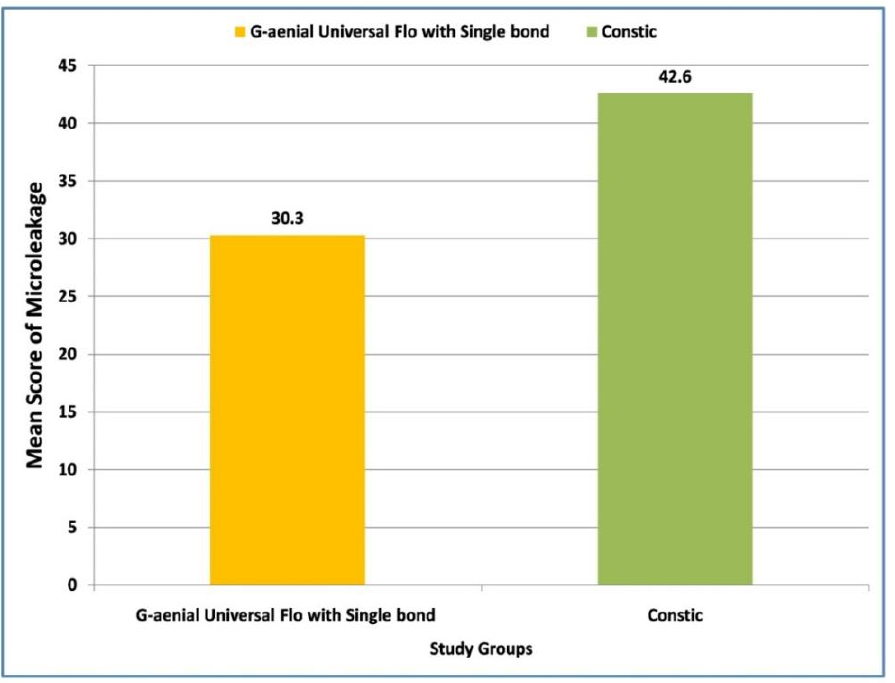
Figure 3. Comparison of mean values of microleakage in class V cavities with Single Bond and Constic, using G-aenial Universal Flo.